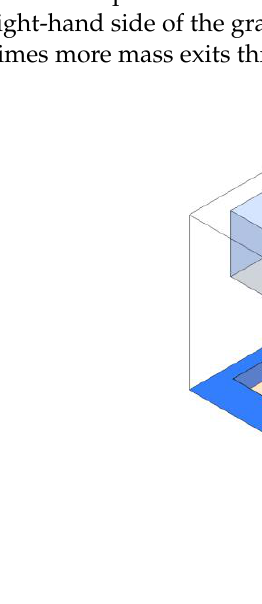
Figure 16. Simulation of process air streamlines, starting from the nozzles: ( a ) for a scenario with fiber flight; ( b ) the same scenario with optimized suction pressure.